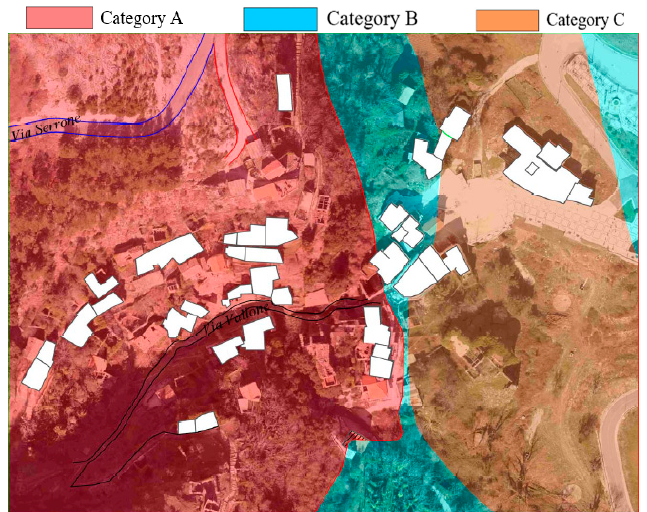
Figure 11. The geomorphologic characterisation of the area of Senerchia.